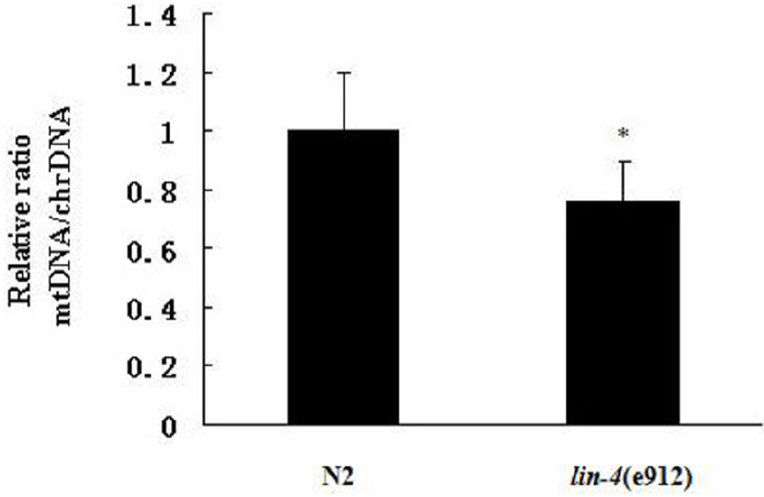
Figure 4. Effects of lin-4 mutation on copy number of mtDNA. The mtDNA copy number was measured in wild-type (N2) and lin-4 mutant (e912) worms. Values represent the mtDNA copy number per worm. At least three replicates were performed. * p <